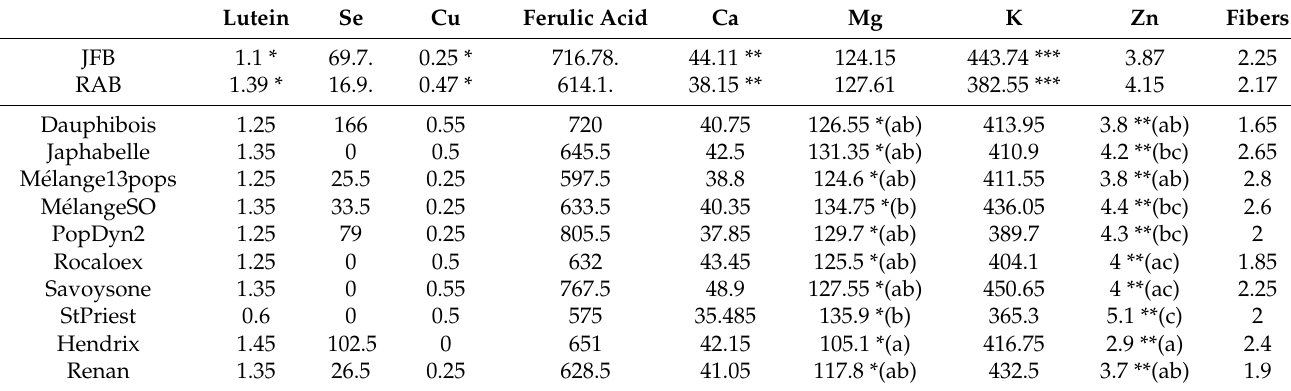
Table 2. Mean values and ANOVA Significance for lutein, selenium (Se), copper (Cu), ferulic acid, calcium (Ca), magne- sium (Mg), potassium (K), zinc (Zn) and fibers. Signifiance codes: 0 ‘***’ 0.001 ‘**’ 0.01 ‘*’ 0.05 ‘.’ 0.1 ‘ ‘ 1.